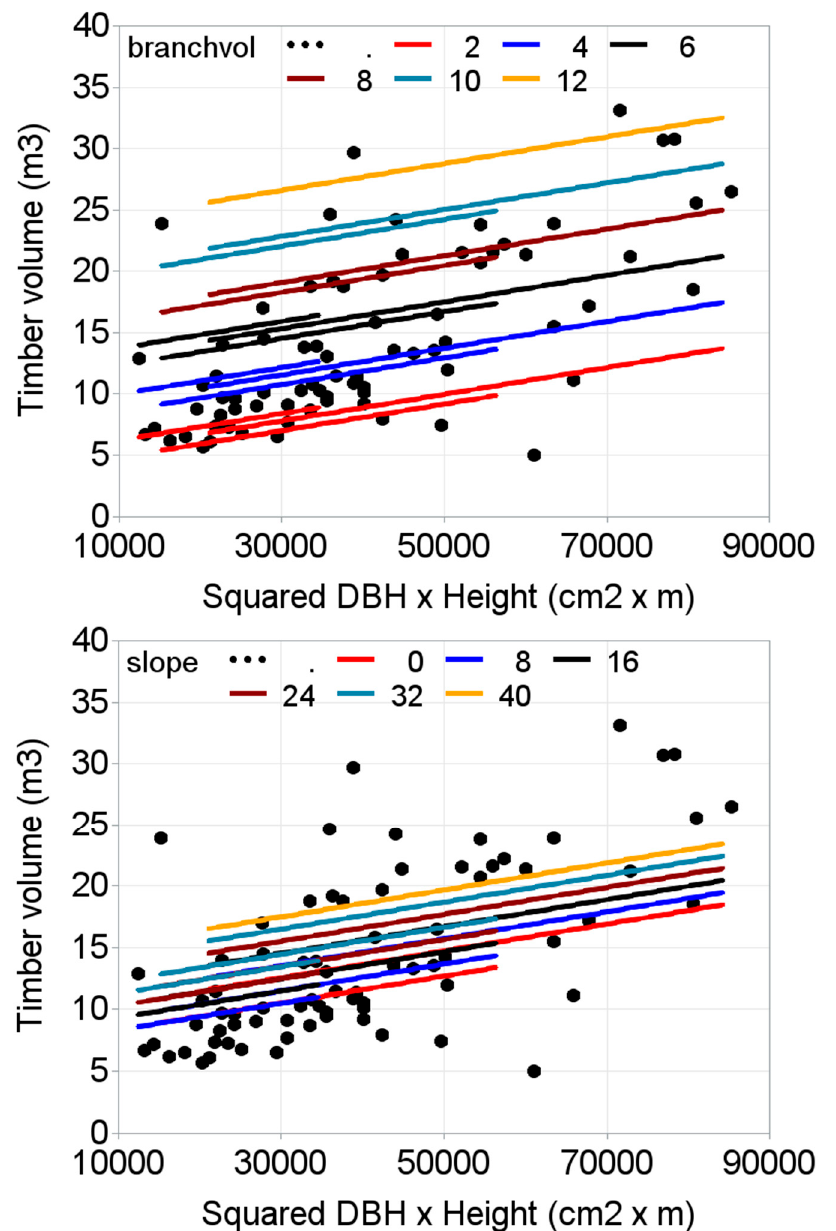
Figure 8. E ff ects of the branch volume (branchvol) and degree of slope on the timber volume prediction. Curves were produced using parameter estimates of the timber volume prediction model (Equation (3)) and the mean of each of the predictors; except the variable of interest in the figure, which was allowed varying from approximately minimum to maximum in the measured data (Table 1). Black dots represent the measured timber volumes.